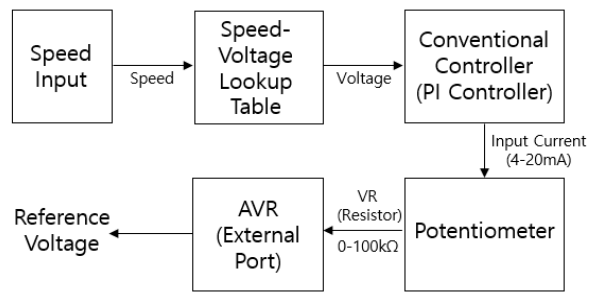
Figure 8. Schematic diagram of the automatic voltage regulator in the testbed.